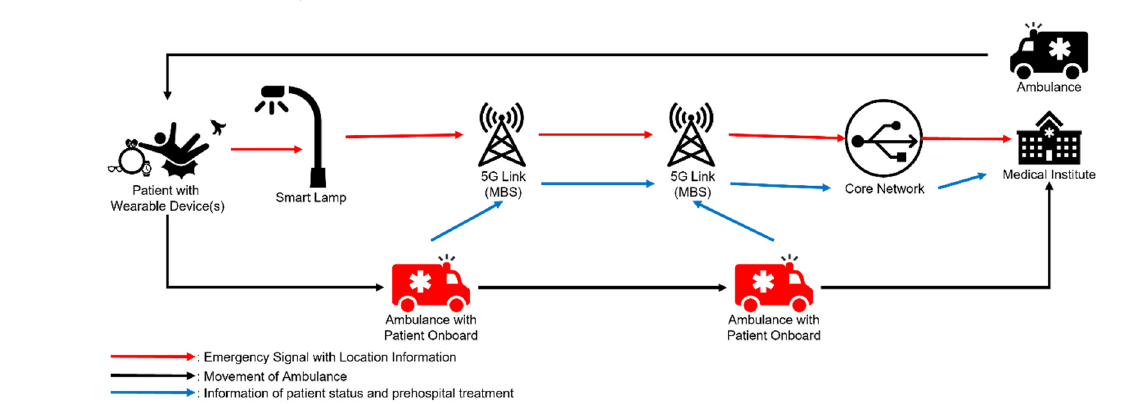
Figure 1. System structure of proposed scheme.